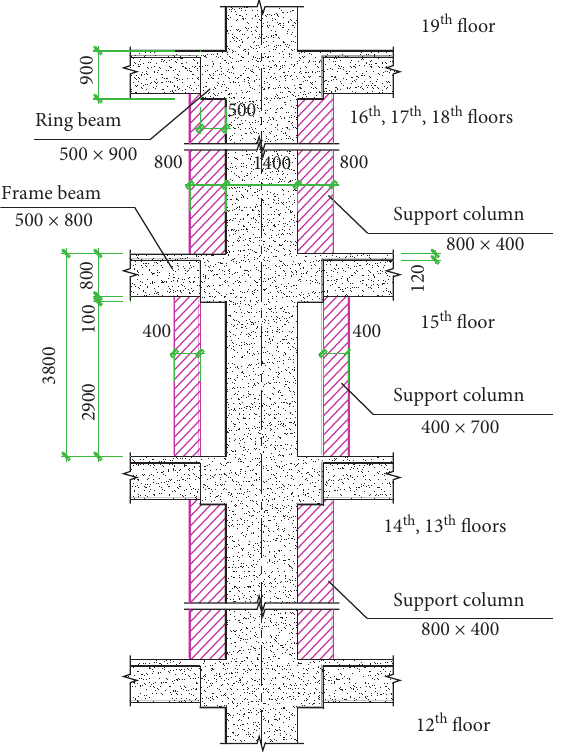
Figure 3: Design of temporary support